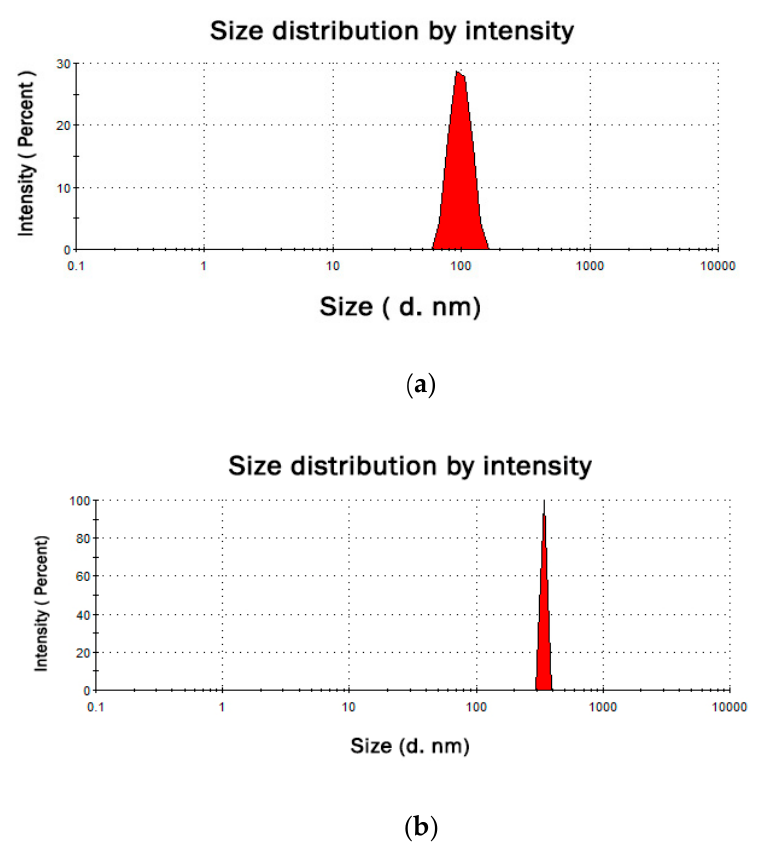
Figure 1. DLS size distribution graph for synthesized zinc nano- ( a ) and microparticles ( b ).